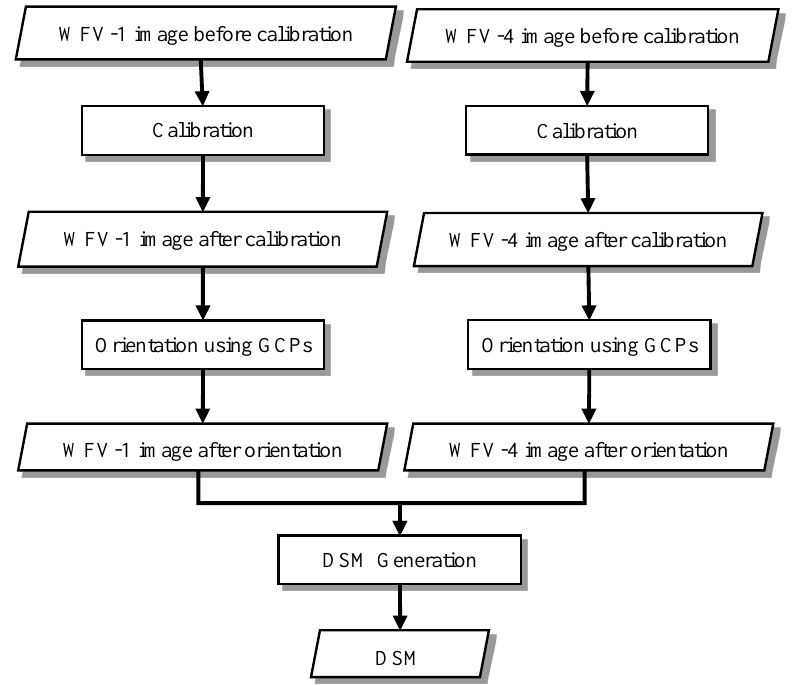
Figure 4 . Wide swath stereo mapping process using the GF-1 WFV images. Step 1: the calibration is to correct for the systematic nonlinear distortion and acquire post-calibration images. Step 2: to determine elements of absolute orientation in two images. ‘GCPs’ stands for ground control points. Step 3: to acquire the corresponding points and generate a digital surface model (DSM) from point